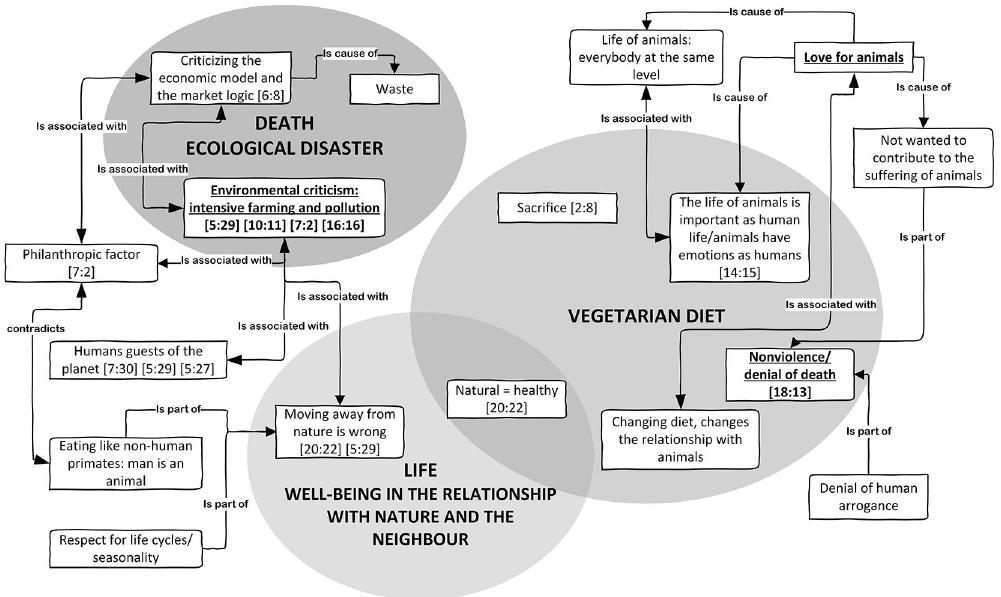
Figure 2. Life as environmental quality. Note. In each box of the graph, the first number in brackets indicates the quotations size (total number of quotations of the code), while the second number indicates the quotation cited in the text as